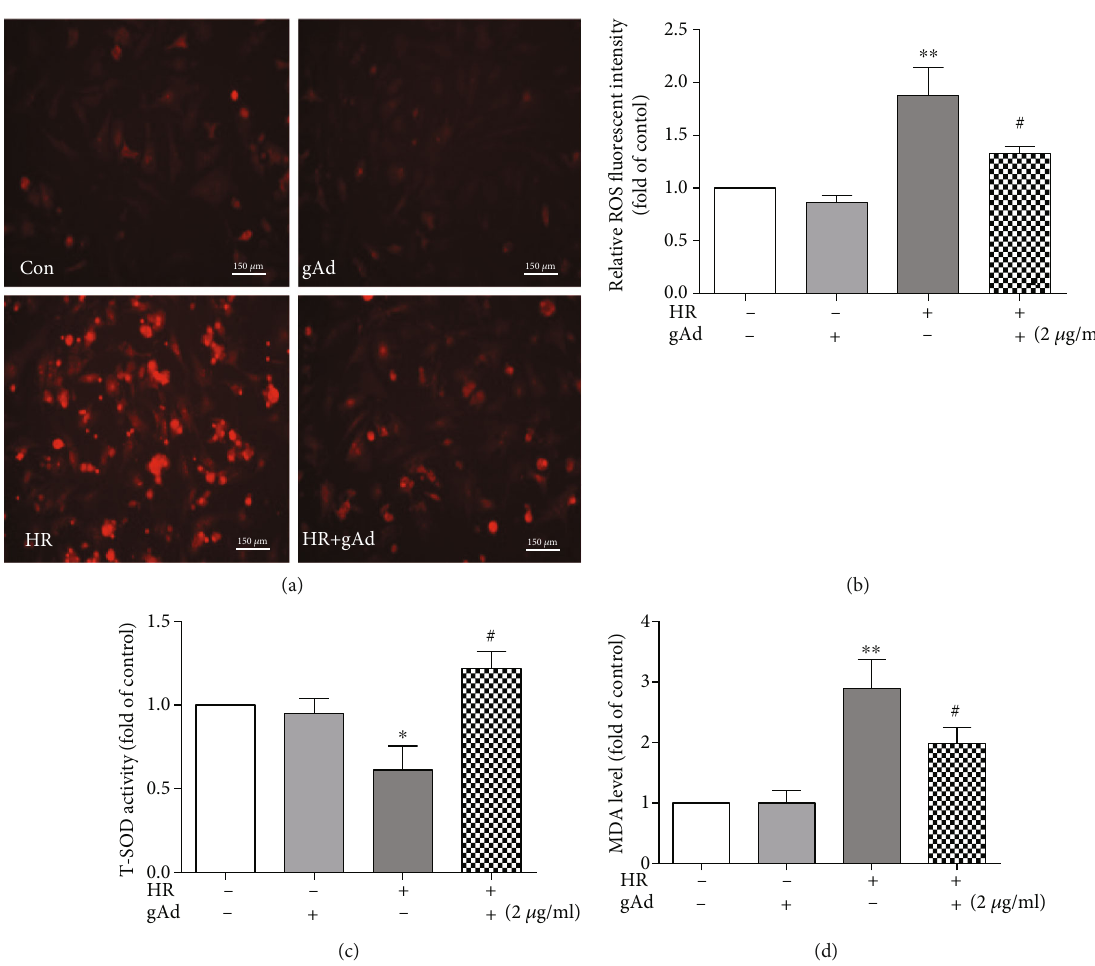
Figure 5: gAd protected cardiomyocyte by attenuation of oxidative stress and activation of the p38/NF- κ B signaling pathway during hypoxia/reoxygenation. (a) The ROS levels were measured using DHE (red) staining ( n = 4 , scale bar, 100 μ m). (b) The bar fi gures show the ROS fl uorescent intensity. (c) T-SOD activities were examined using the hydroxylamine method ( n = 7 ). (d) The MDA levels were examined using the TBA method ( n = 4